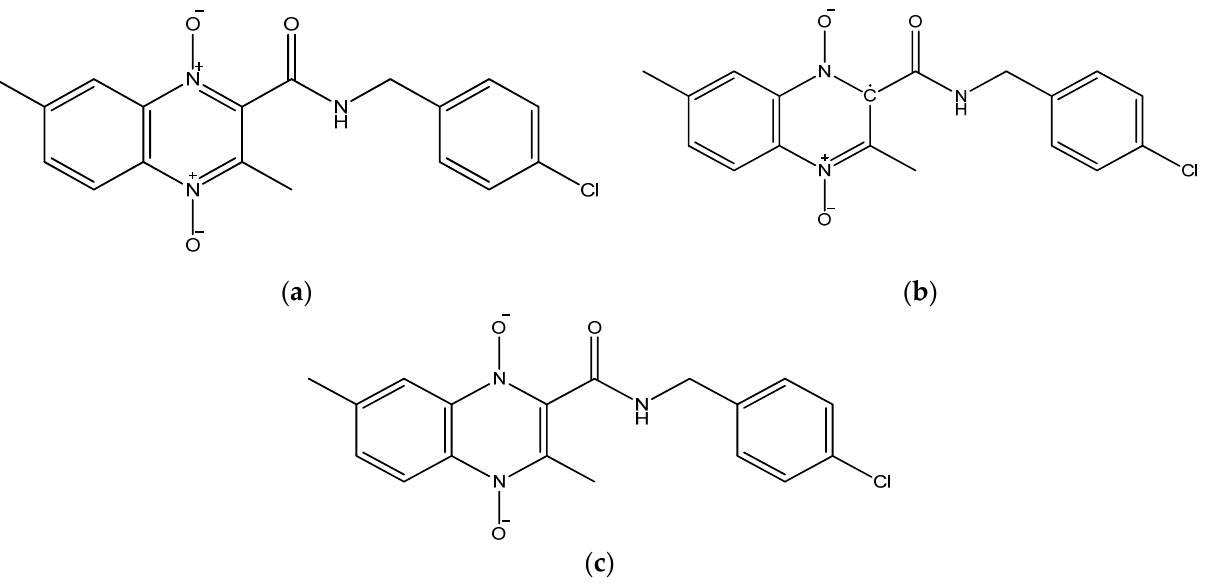
Figure 1. The molecular structures of Compound 20 [18] in ( a ) neutral, ( b ) the anion product from the 1st N-oxide reduction (Wave 1), and ( c ) the dianion product from the 2nd N-oxide reduction (Wave 2) drawn with ChemDraw [33].